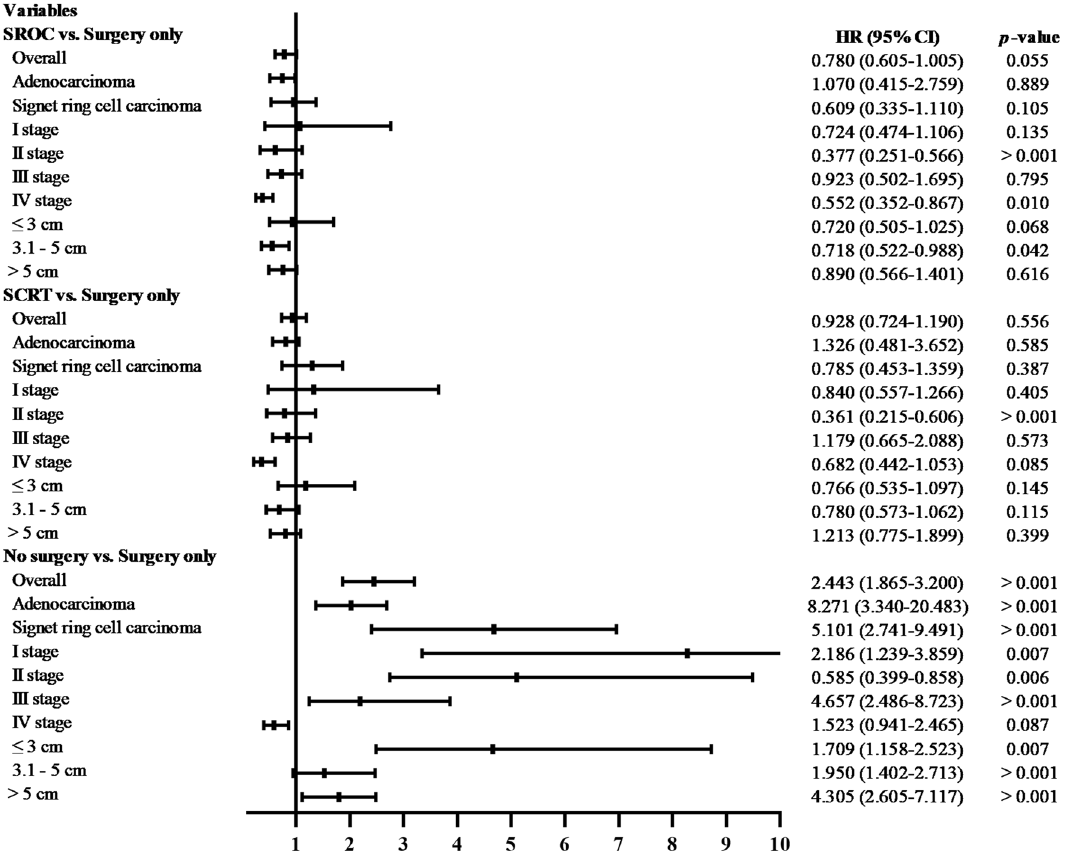
Figure 6. Overall survival of study subgroups in multivariable analyses. (Surgery alone as a reference). SROC, surgery plus radiotherapy or chemotherapy; SCRT, surgery plus chemoradiotherapy; HR, hazard ratio; CI, confidence Interval.